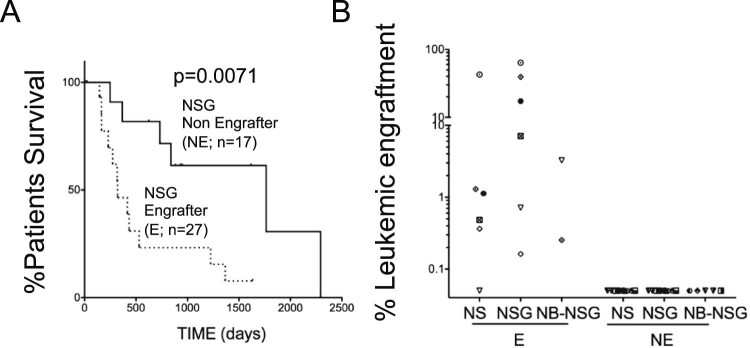
Better outcome AML cannot engraft adult and newborn NSG mice. (A) Patients with AML cells devoid of xenograft potential in NSG mice (n = 17) have better overall survival than engrafter AML (n = 27). Data show Kaplan-Meier 6 years survival curves of de novo AML cases (<60 years old) that received intensive multi-agent chemotherapy. Allografted patients were censored. p = 0.0071 in a Mantel-Cox log rank test. (B) Data show the percentage of engraftment of engrafter (E) and non engrafter (NE) in NOD/SCID (NS) versus NOD/SCID IL-2Rγ common chain null (NSG) or newborn NSG mice (NB-NSG) models. 11 NS NE sample were tested in the NS and NSG model, of which 5 in the NB-NSG model. 6 NS E were tested in the NS and NSG model of which 2 in the NB-NSG model. 1–10 106 T cells depleted mononuclear cells were injected and the leukemic engraftment level was evaluated by FACS at 10 to 12 weeks. Each dot represents the mean engraftment level of a single AML sample determined for n = 2 to 12 animals per sample.